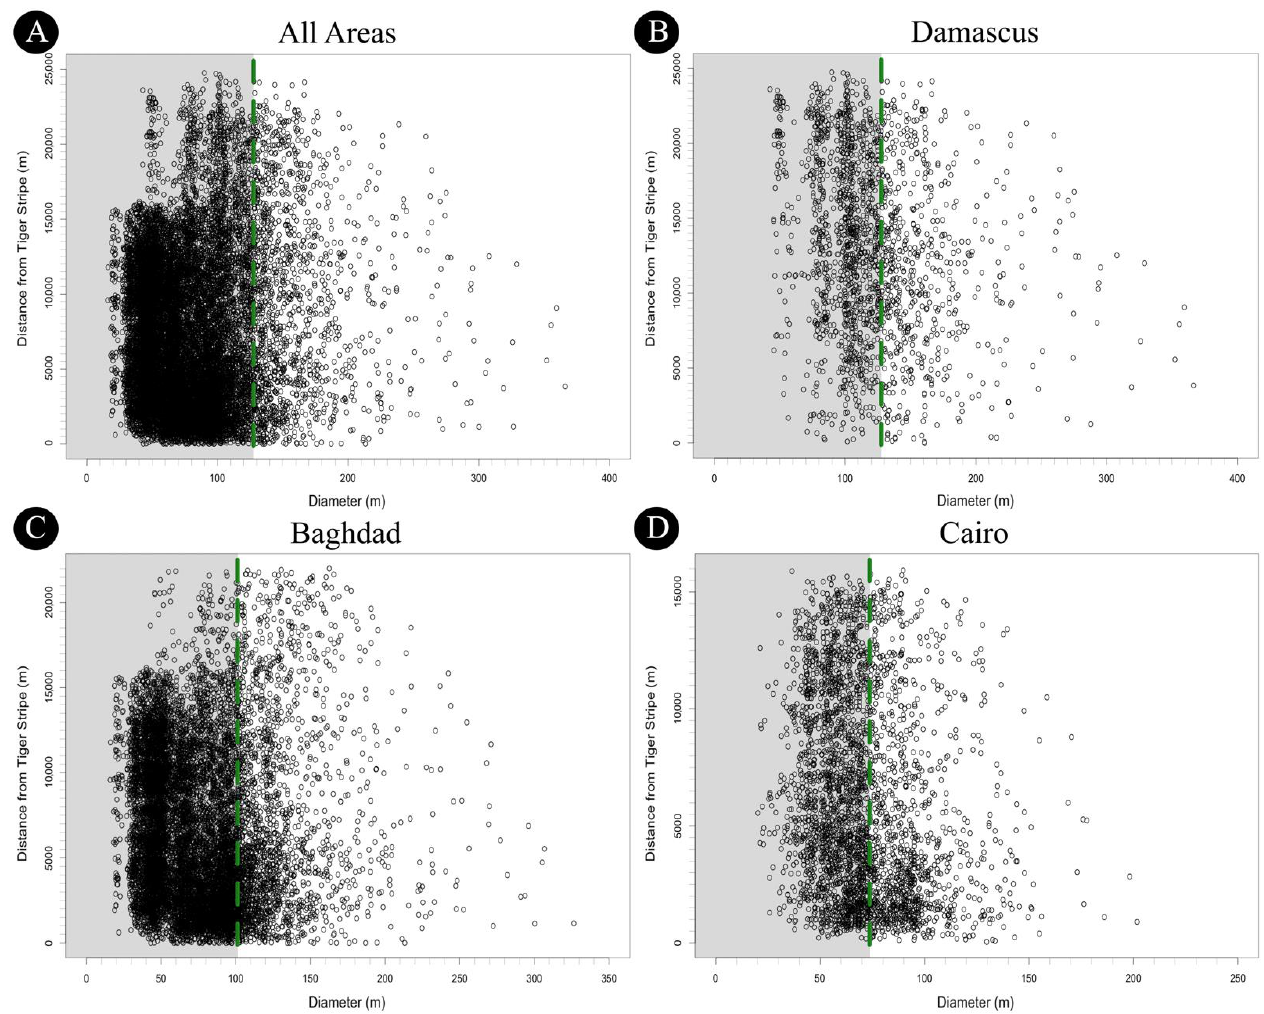
Figure 12. Diameter versus TS distance plots obtained for all counts ( A ), for the Damascus blocks ( B ), for the Baghdad counts ( C ) and for the Cairo blocks ( D ). The vertical green dashed lines are the four pixels limit derived for each case, see Figures 5 and 8. On all plots, the counts located inside the grey shadowed area are not considered because they are below the four pixels identification limit.